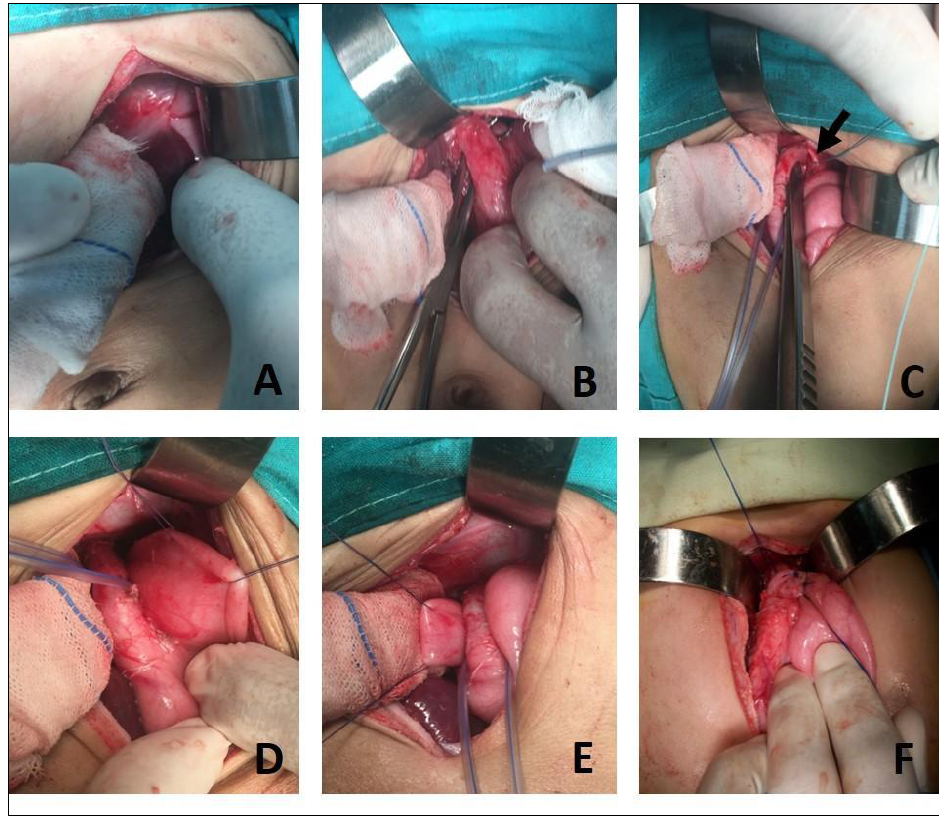
Figure 1: It shows the operative steps of Nissen fundoplication. A: mobilization of the left lobe of the liver to expose the esophageal hiatus; B: mobilization of the lower 2 cm of the esophagus; C: repair of esophageal hiatus if needed (arrow points to left crus; D: the released fundus after ligation and division of short gastric vessels; E: passing the gastric fundus through the retro-esophageal space; F: the creation of floppy 360° fundal